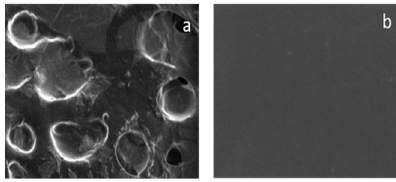
Figure 11. Photomicrography of empty SLN (Mag = 100 X) ( a ) and of gel based on HA and Poloxamer 407 containing empty SLN (Mag = 1.00 K X) ( b ).